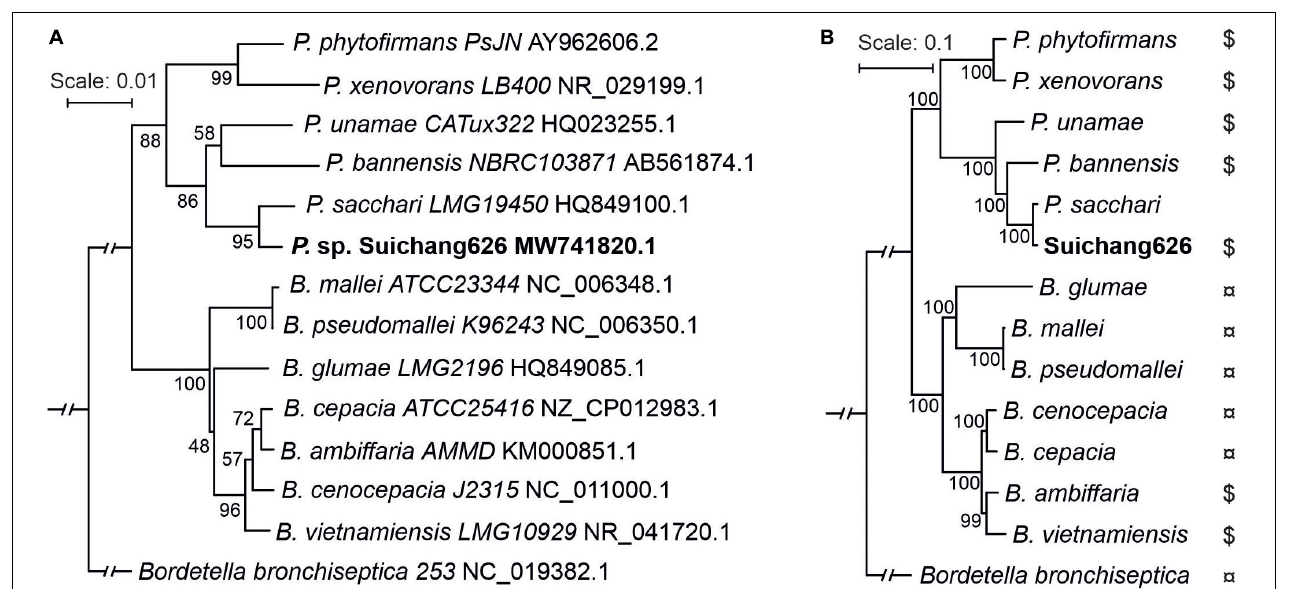
FIGURE 2 | Phylogenetic trees of representative species from genus Paraburkholderia and Burkholderia using 16S rRNA sequence and genome-wide single-copy protein sequences. (A) The 16S rRNA sequences were collected from NCBI or searched from genomes by BLASTn. Bordetella bronchiseptica was selected as outgroup. Sequence alignment was performed using ClustalX2 and aligned regions were applied as input for RAxML tree building. Rapid bootstrapping model (1,000 × ) was chosen. Bootstrap percentage values are indicated at each node. (B) Phylogenetic tree constructed by using 795 single-copy protein sequences. Protein sequences were selected from genome annotations. Single-copy proteins were produced with orthofinder (default settings). Sequence alignment quality control was achieved by applying sequence scores ≥ 0.8 in MAFFT analysis with Guidance2. Multiple aligned sequences were gathered into one sequence using FASconCAT_V1.0. RAxML and rapid bootstrapping (100 × ) were used for constructing phylogenetic tree. Bootstrap values are indicated at each node. $, plant beneficial bacteria; ¤, plant/animal